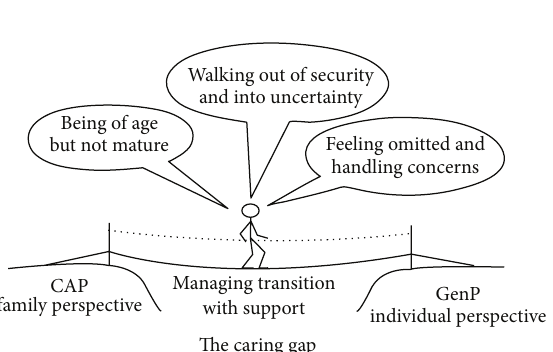
Figure 1: Managing transition with support. A description of how young adults and their relatives need support to manage the transition and avoid the caring